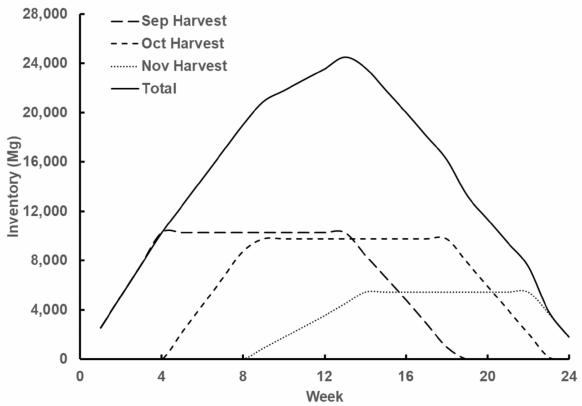
Figure 6. Inventory in SSLs for weeks 1 through 48 for the six-month window. (Results obtained with the Scenario 2 MATLAB program).